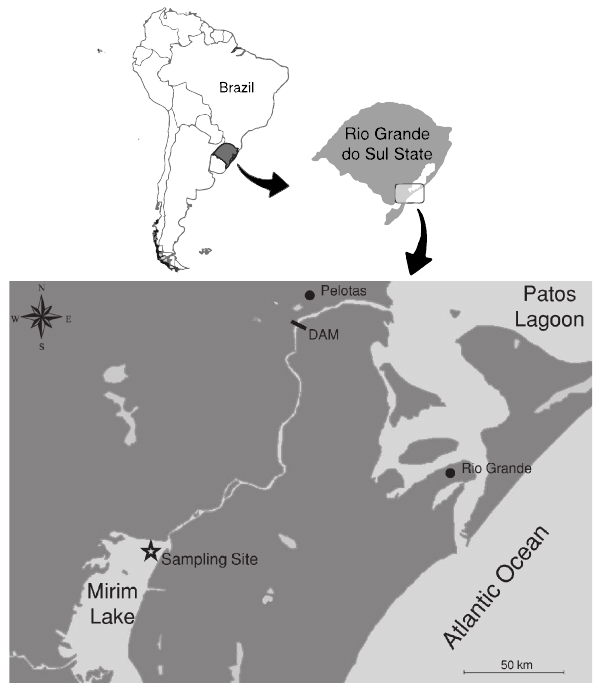
Figure 1. Map of South America and Brazil, highlighting the state of Rio Grande do Sul and the northern portion of the Mirim Lake. Star represents the sampling